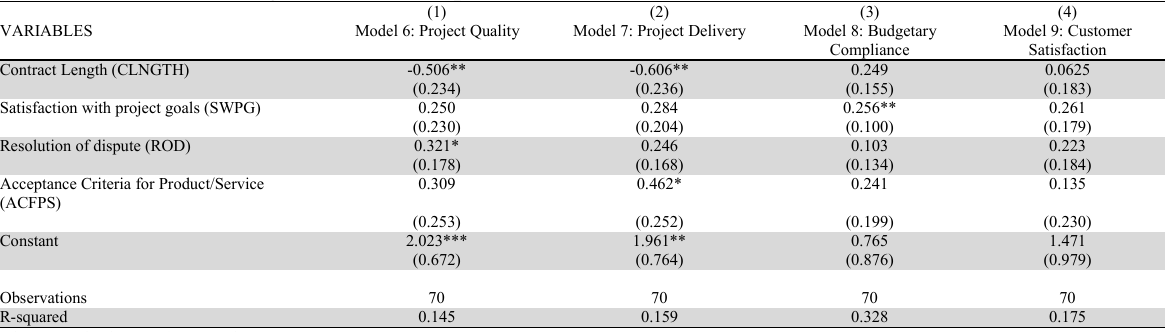
Effect of Contract Management on Firm